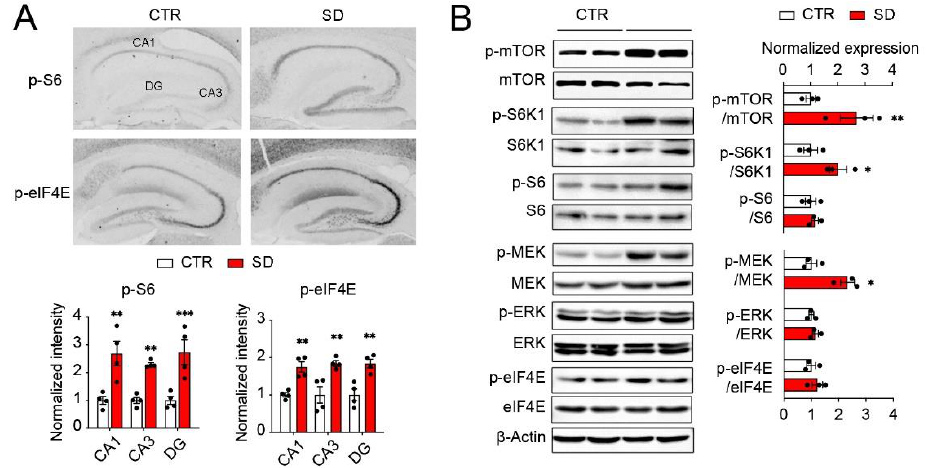
Figure 4. Hyperactivation of mTOR and ERK MAPK pathways in the hippocampi of SD mice. ( A ) Representative microscopic images of the sagittal hippocampus sections immunostained for p-S6 and p-eIF4E in the CTR and SD mice. Quantitation of staining intensities in hippocampal CA1, CA3, and DG areas are shown below. Note significant increases in the p-S6 and p-eIF4E levels in the hippocampi of SD mice. Data are displayed as individual values and mean ± SEM. n = 4 in CTR and SD. *** p < 0.001; ** p < 0.01 vs. CTR. ( B ) Western blots indicate upregulation of mTOR/S6K1/S6 and MEK/ERK/eIF4E kinase activities in the forebrains of SD mice compared with CTR mice. Quantitative analysis is shown to the right. Data are displayed as individual values and mean ± SEM. n = 3 in CTR and SD. ** p < 0.01; * p < 0.05 vs. CTR.